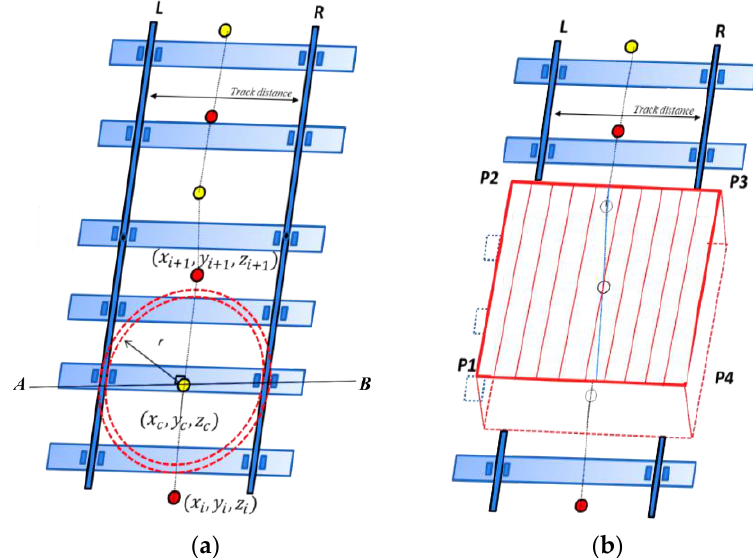
Figure 5. The recorded GNSS for ( a ) boundary coordinate estimation and ( b ) vertical slice definition. Remote Sens. 2019 , 11 , x FOR PEER REVIEW